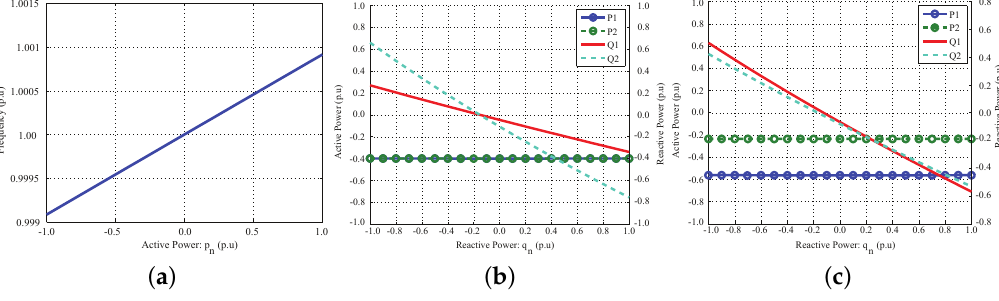
Figure 9. Steady-state response of the converter power with respect to q n ( b , c ), and frequency variation with respect to p n ( a ). ( a ) p n = 0.8 p.u, q n = − 0.1 p.u, α = 0.3, β = 0.7; ( b ) p n = 0.8 p.u, q n = − 0.1 p.u, α = 0.5, β = 0.7; ( c ) p n = 0.8 p.u, q n = − 0.1 p.u, α = 0.3, β =